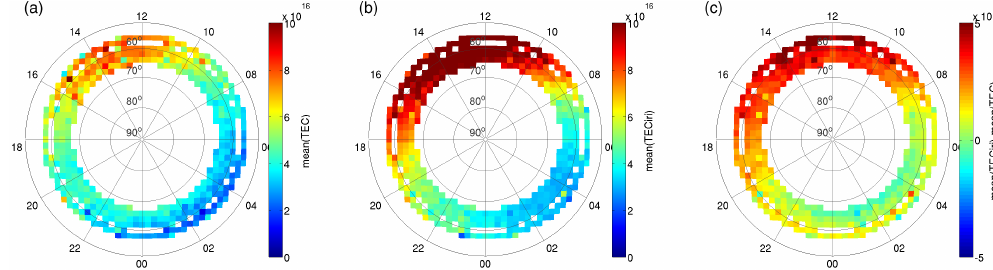
Figure 5. Magnetic local time mean values for tomographic VTEC, corresponding IRI-2012 values and the difference between the two.